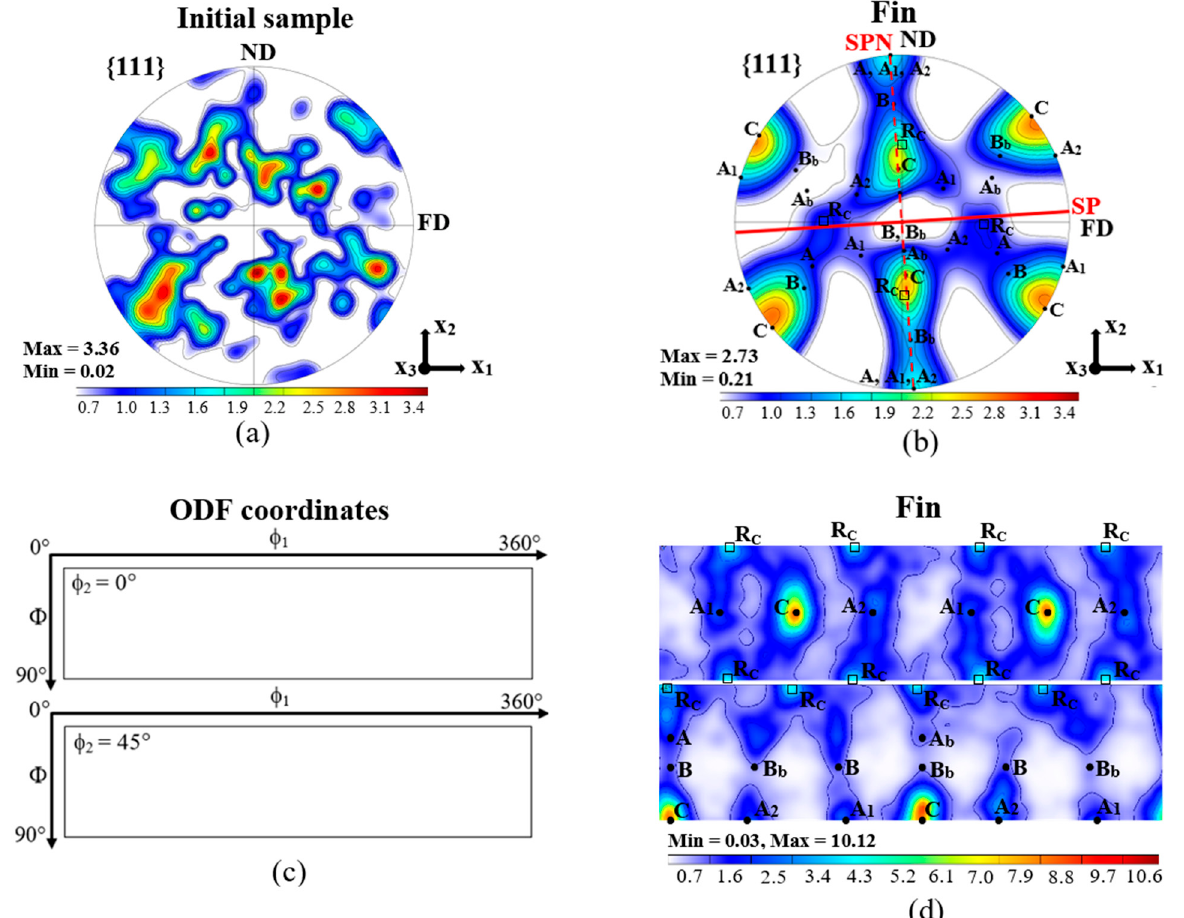
Figure 6. ( a ) Crystallographic texture of the initial sample, ( b ) pole figure after FALEP processing (SP: shear plane, SPN: shear plane normal), ( c ) key figure for the ODF sections, and ( d ) ODF after FALEP processing. (Rc: rotated cube compo- nent.)